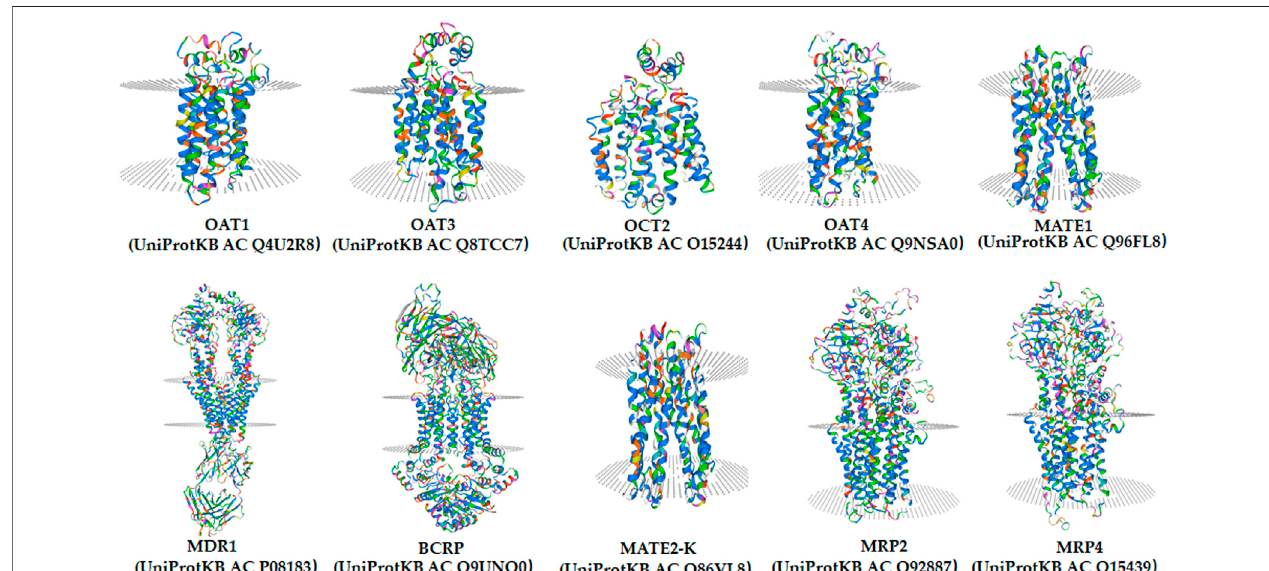
FIGURE 3 | The homology models of OAT1, OAT3, OCT2, MDR1, BCRP, MATE1, MATE2-K, OAT4, MRP2, and MRP4 in human from SWISS-MODEL (https:// swissmodel.expasy.org/).